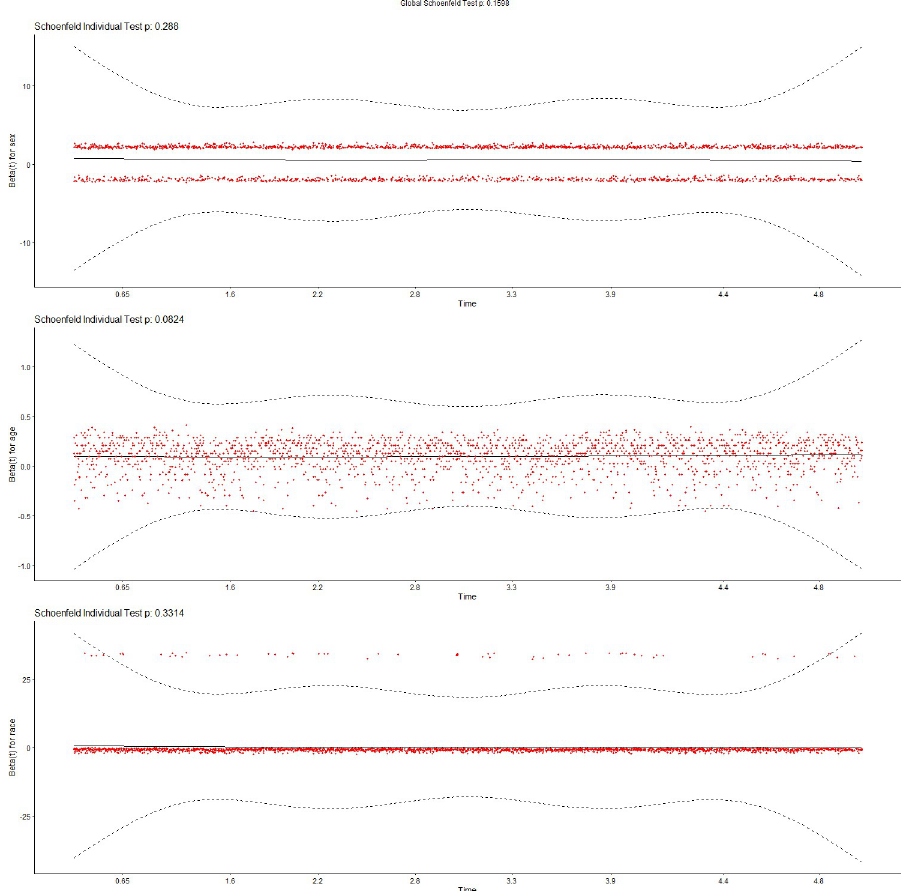
Fig 7. Feature tests for proportionality of risks: